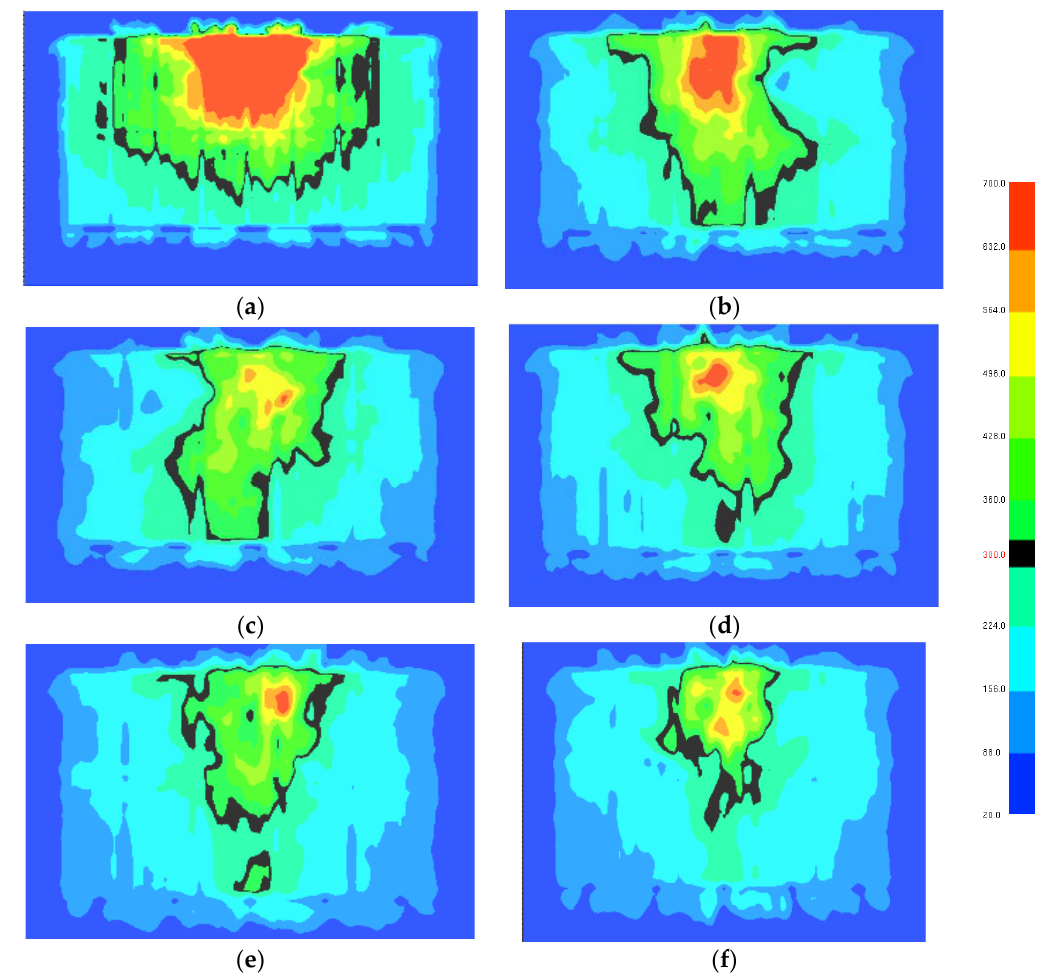
Figure 3. Influence range on the ceiling at different bridge deck spacings: ( a ) H = 9.8; ( b ) H = 10.6; ( c ) H = 11.4; ( d ) H = 12.2; ( e ) H = 13.0; ( f ) H = 13.8.